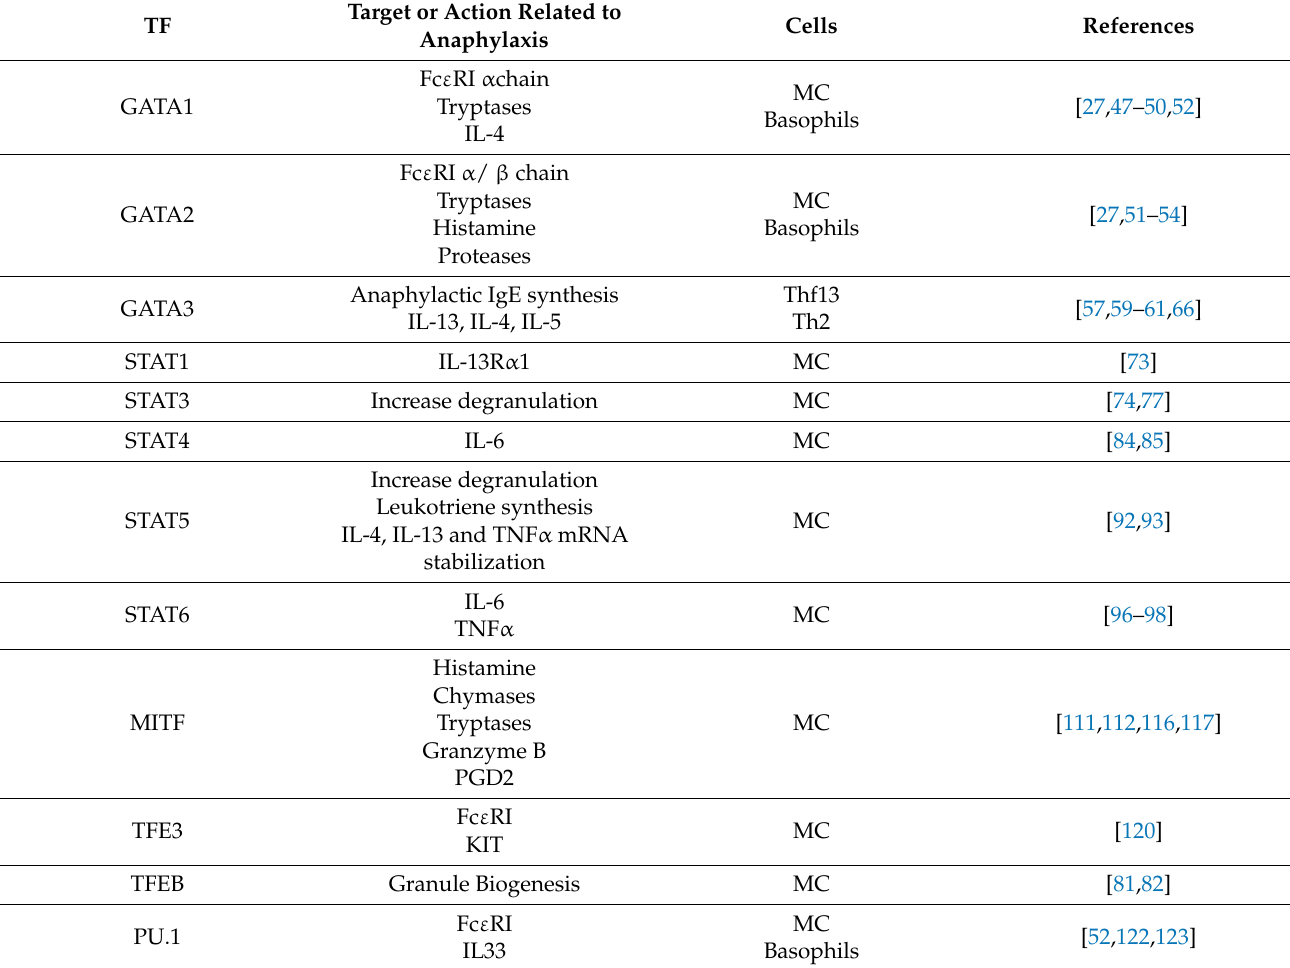
Table 1. Transcription factors relevant to IgE-dependent anaphylaxis and their targets or mechanisms described. Target or Action Related to TF Anaphylaxis